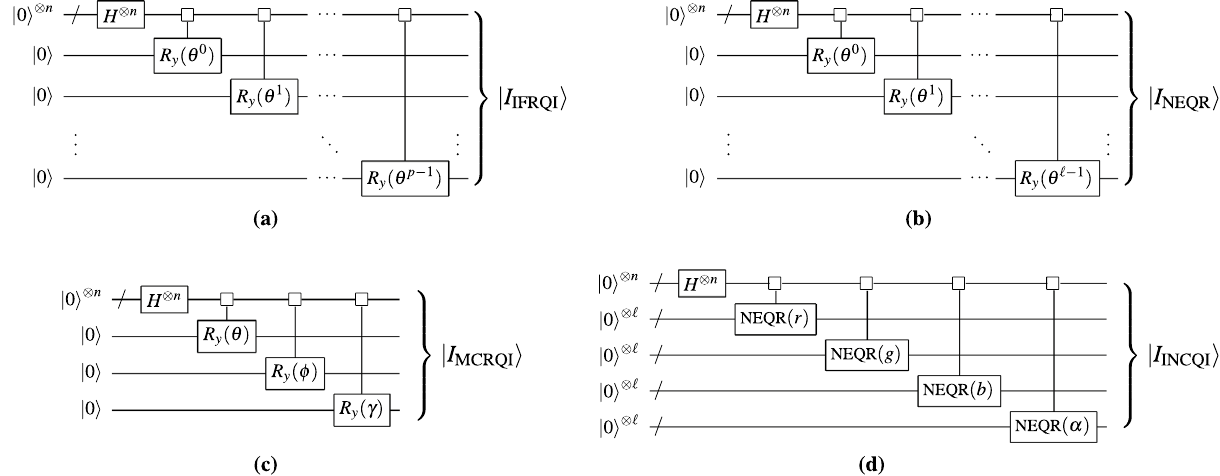
Figure 3. Circuits for the preparation of the IFRQI, NEQR, MCRQI, and INCQI states, where the uniformly controlled rotations can be compressed with our